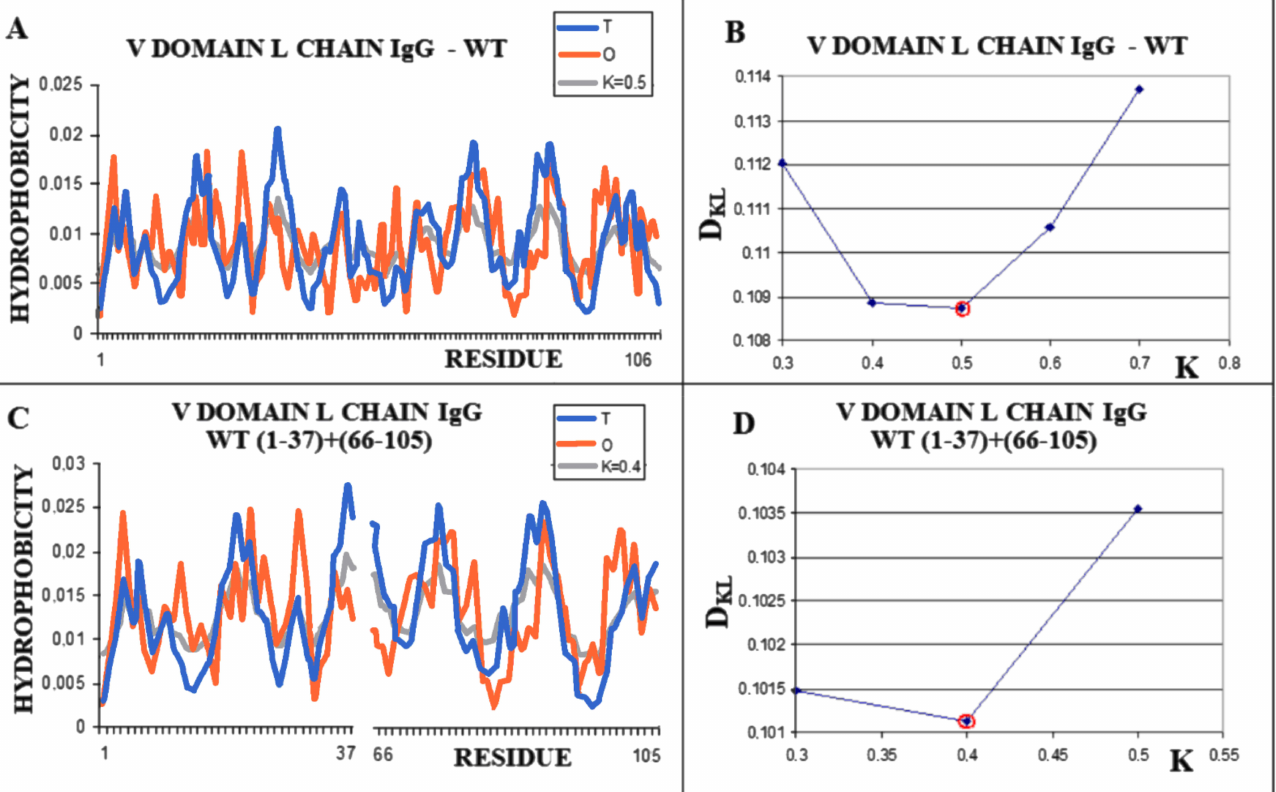
Figure 4. Structural characteristics of the V domain of the IgG light chain in its WT form. ( A )—Profiles of T-navy blue, O-red, and M-gray for the complete chain. The M distribution is obtained for the parameter K = 0.5. ( B )—Change in the D KL value for the O–M relation with different values of the K parameter. The lowest value was indicated as representing the shortest distance. ( C )—Profiles of T-navy blue, O-red, and M-gray for the WT form of V domain hover limited to fragments present in amyloid form. The M distribution is obtained for the parameter K = 0.4. ( D )—Change in the D KL value for the O–M relation with different values of the K parameter. The lowest value was indicated as representing the shortest distance between the O and M